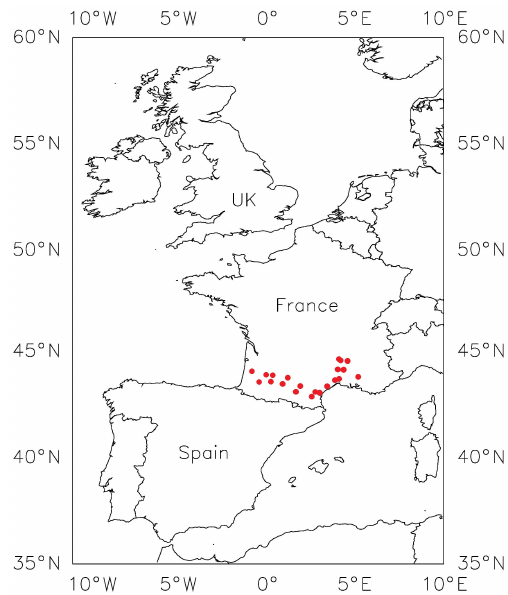
Figure 1. Location of the 21 SMOSMANIA stations in southern France (see station names in Supplement